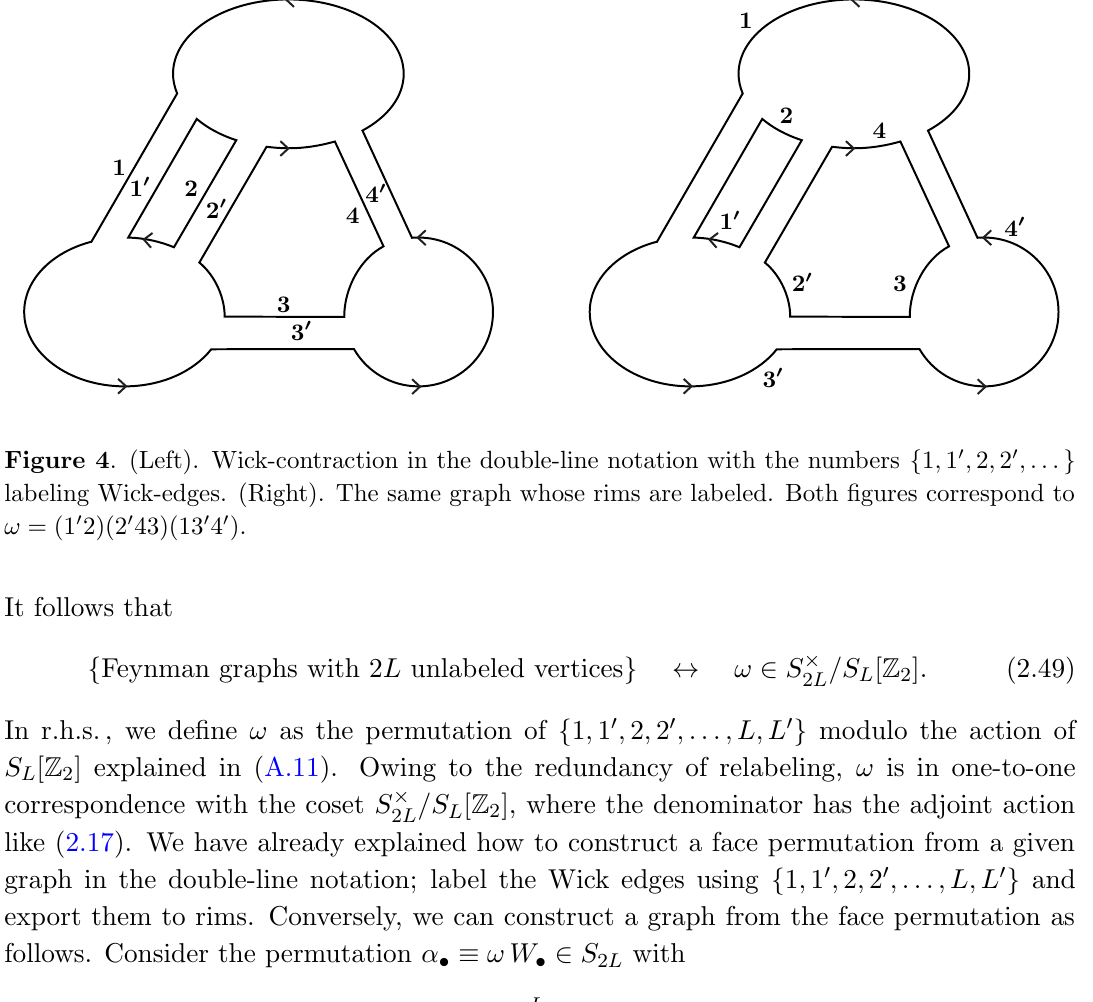
Figure 3 . (Left) Wick-contraction in the half-edge notation, see appendix A.3. This is the Cayley graph generated by (cid:19) (cid:11) = ( a 1 0 a 2 )( b 1 0 b 2 )( c 1 0 c 2 ) : : : and W = ( A 1 B 2 )( B 1 C 2 )( C 1 A 1 ) : : : . (Right) The same graph whose rim between a (cid:22) and a is labeled as P . (cid:11) ( P ) P